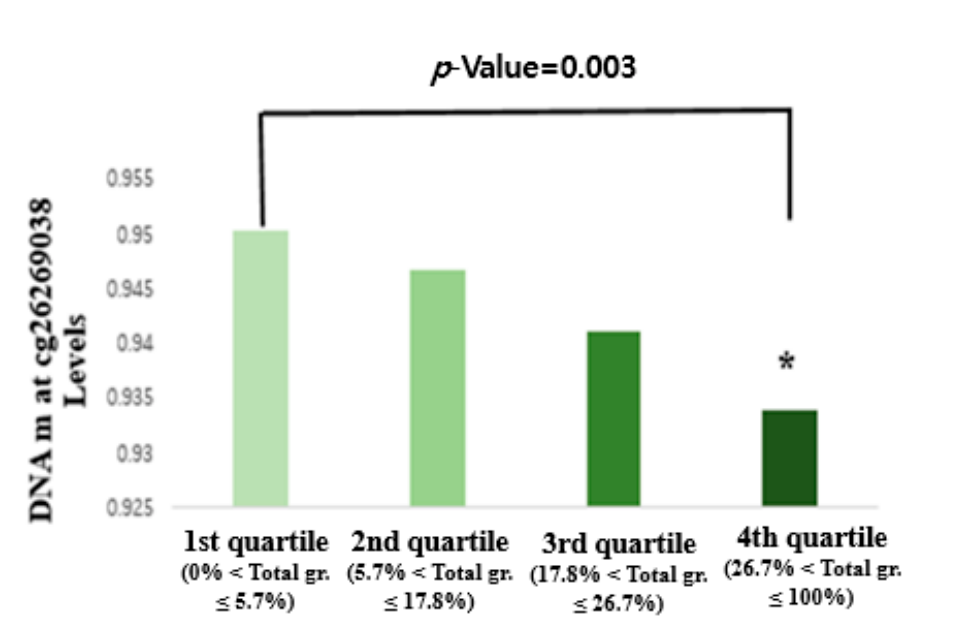
Figure 3. The LSMEANS of DNA m at cg26269038 levels in four quartiles of exposure to greenness among children. * Represents significant differences between a quartile and the lowest quartile, with p -values < 0.05 considered statistically significant.